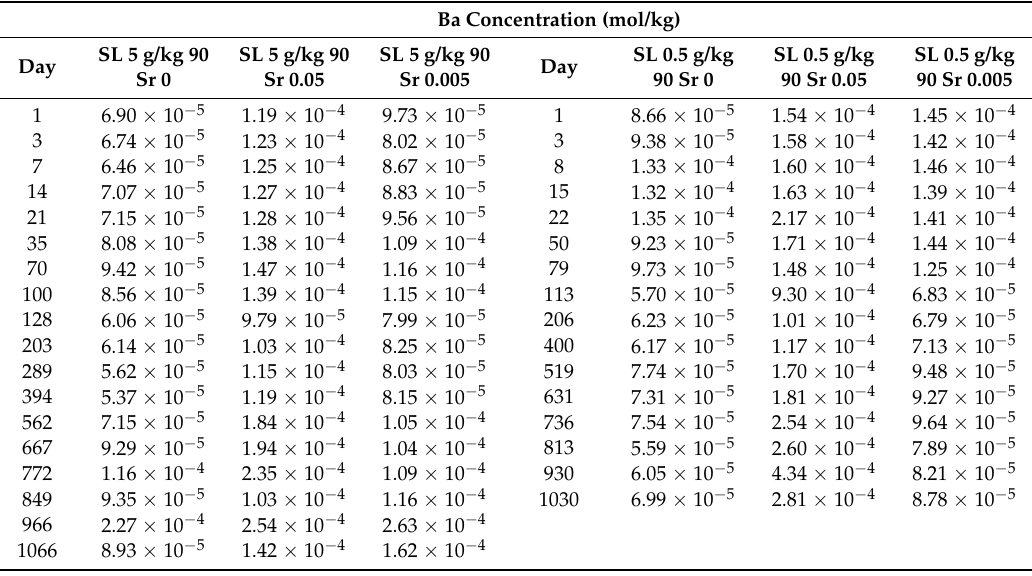
Table A8. Ba concentration of experiments with Sr in the aqueous solution at 90 ◦ C.